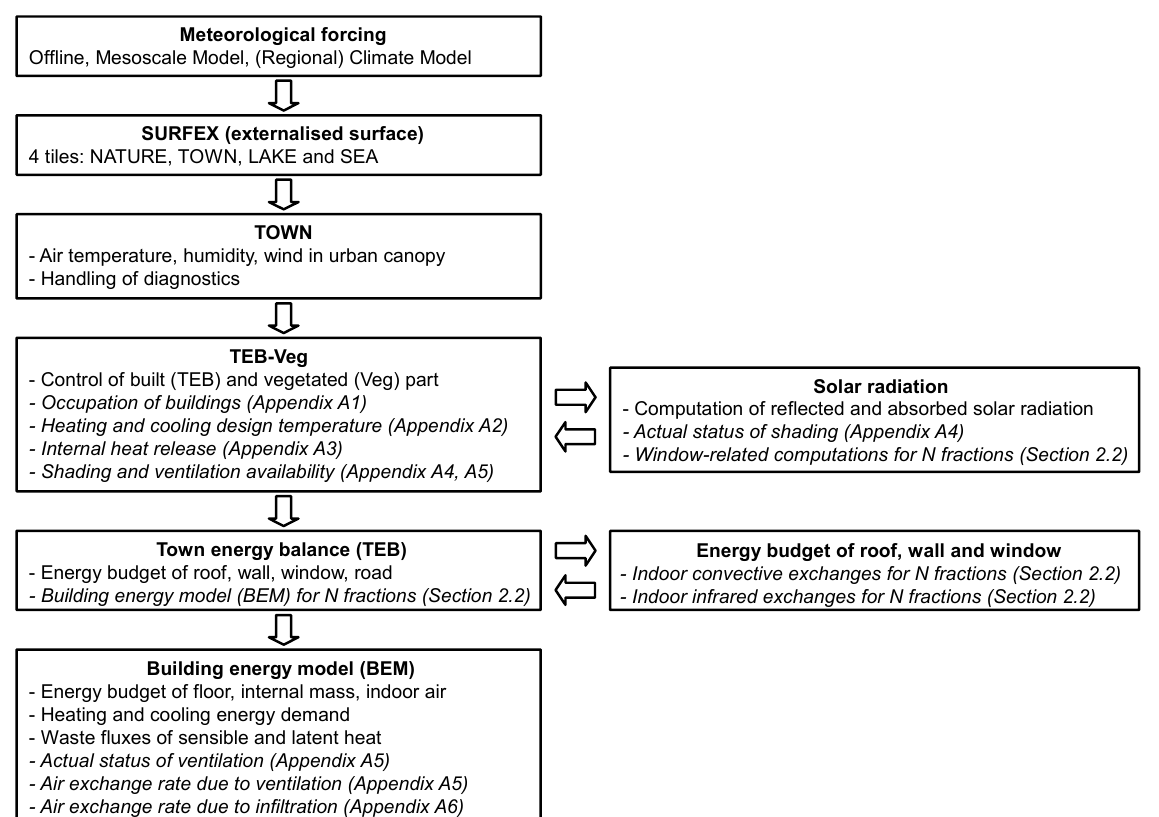
Figure 1. Overview of the components of SURFEX-TEB relevant to human behaviour and building energy consumption. The main modifi- cations are in italics